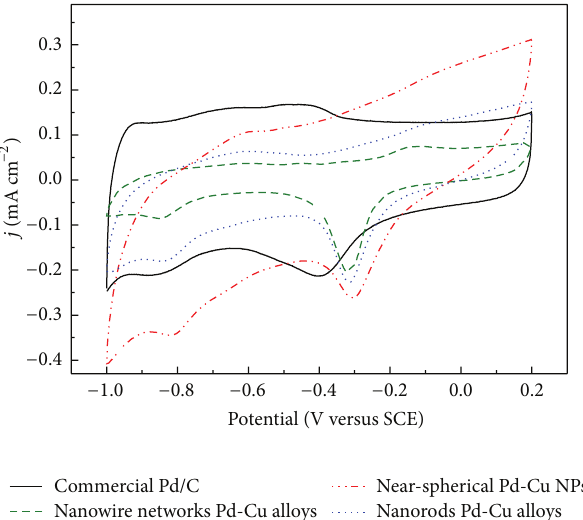
Figure 6: CV curves of modified electrodes for commercial Pd/C, near-spherical Pd-Cu NPs, nanorods Pd-Cu alloys, and nanowire networks Pd-Cu alloys in 0.5 M KOH at a scan rate of 50 mVs −1